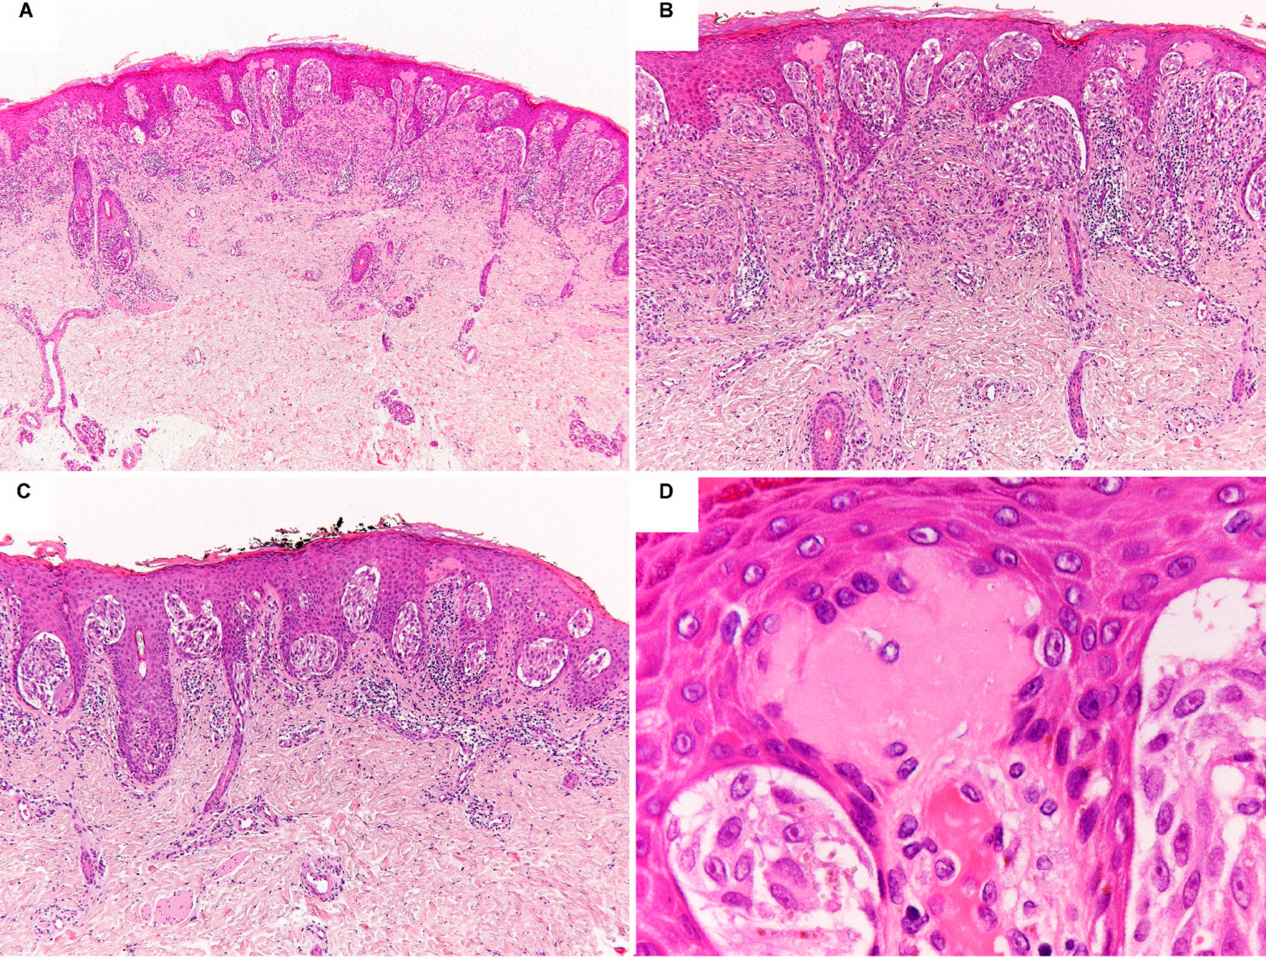
Figure 1. Photomicrographs of a prototypical Spitz nevus showing a symmetric, slightly raised, compound, and maturating melanocytic proliferation with epidermal hyperplasia, flat base, and scattered Kamino bodies, composed of large clefting nests of spindle and epithelioid melanocytes with abundant eosinophilic cytoplasm, moderately pleomorphic vesicular nuclei, and prominent nucleoli ( A – D ) H&E staining; original magnification 10 × , 100 × , 100 × , and 400 × ,